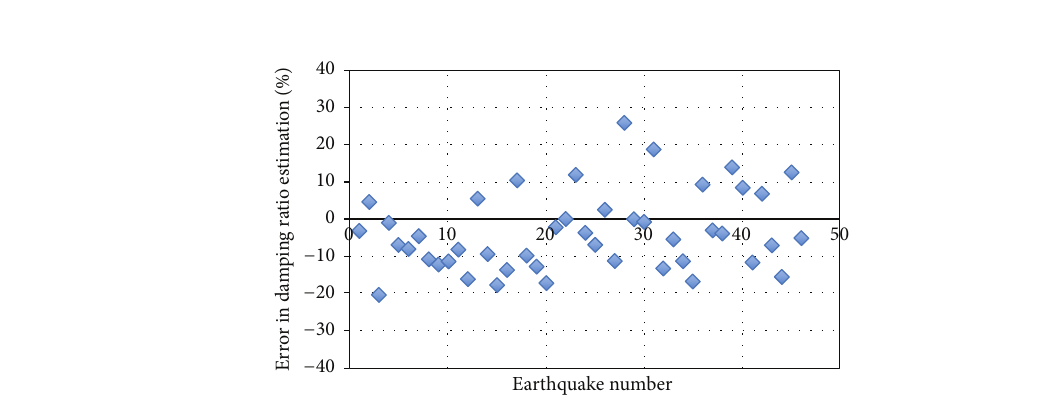
Figure 6: Variation of error in estimation of damping ratio for different earthquake